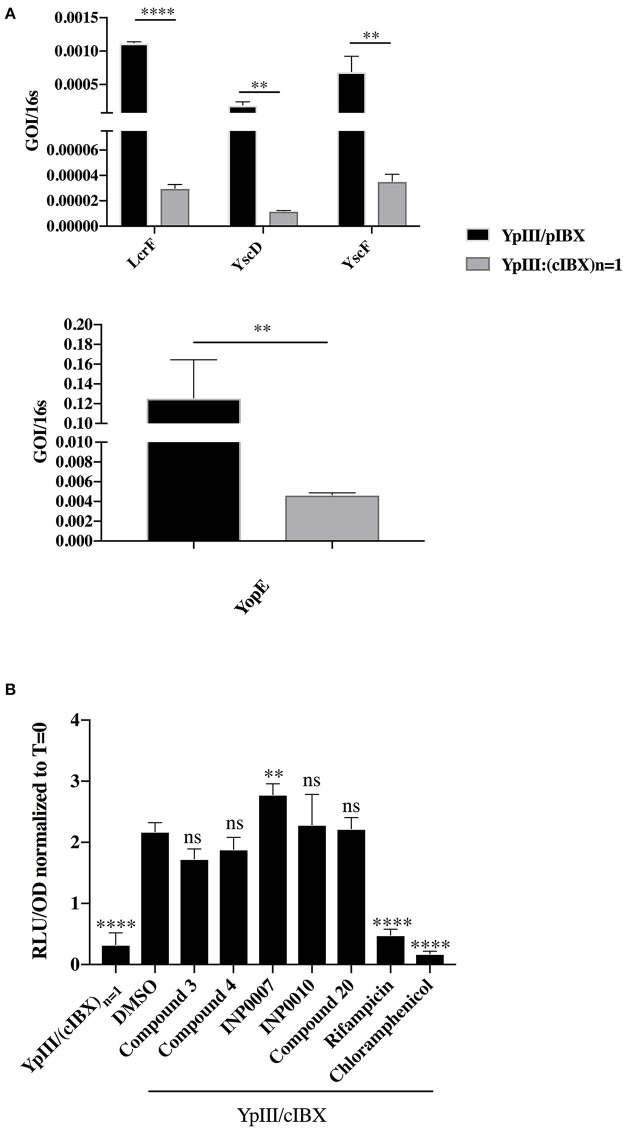
Correlation between pYV copy number and T3SS gene expression. (A)
Y. pseudotuberculosis encoding luciferase genes on pYV (YPIII/pIBX) or a strain in which pYV-encoded T3SS and luciferase genes were incorporated into the chromosome in single copy [YPIII/(cIBX)n = 1] were grown for 3 h under T3SS-inducing conditions in 50 μM compound or equivalent volume of DMSO and T3SS gene expression evaluated by qPCR. GOI, gene of interest. Expression levels were normalized to 16s rRNA and then the fold change compared to DMSO calculated [(GOIcompound/16scompound)/(GOIDMSO/16sDMSO)]. The average of four biological replicates ± standard deviation is shown. ****P < 0.0001, **P < 0.008 (Student T-test). (B)
Y. pseudotuberculosis YpIII/pIBX and YPIII/(cIBX)n = 1 were grown under T3SS-inducing conditions for 3 h in 50 μM compound or equivalent volume of DMSO and luminescence measured as a readout of pYV gene copy number. The average of four biological replicates ± standard deviation is shown and statistical significance is represented comparing compounds relative to the DMSO control. ****P < 0.0001; **P = 0.008 (one way ANOVA with Dunnett's post-hoc test).